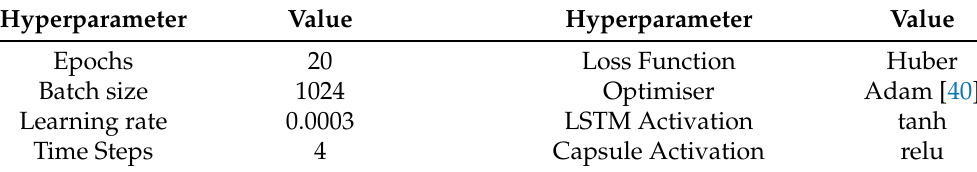
Table 3. Hyperparameter values used across the models for the drone dataset